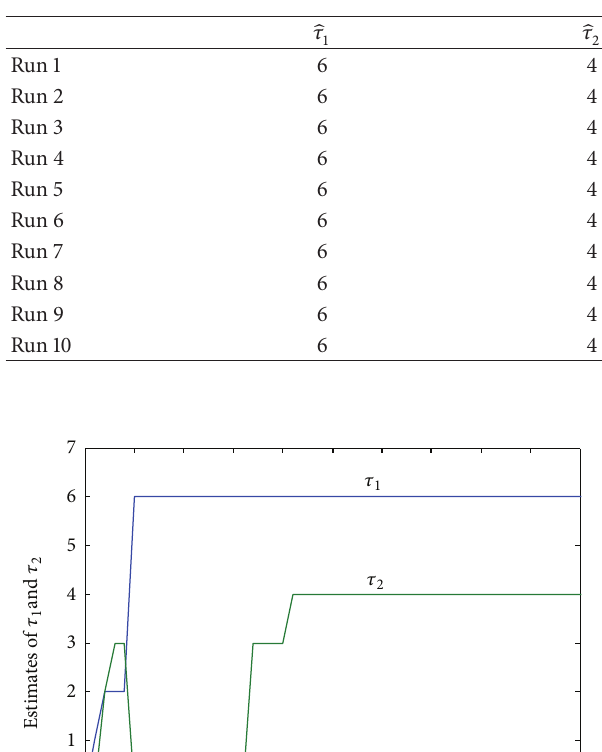
Table 1: Estimation results for Example 1.